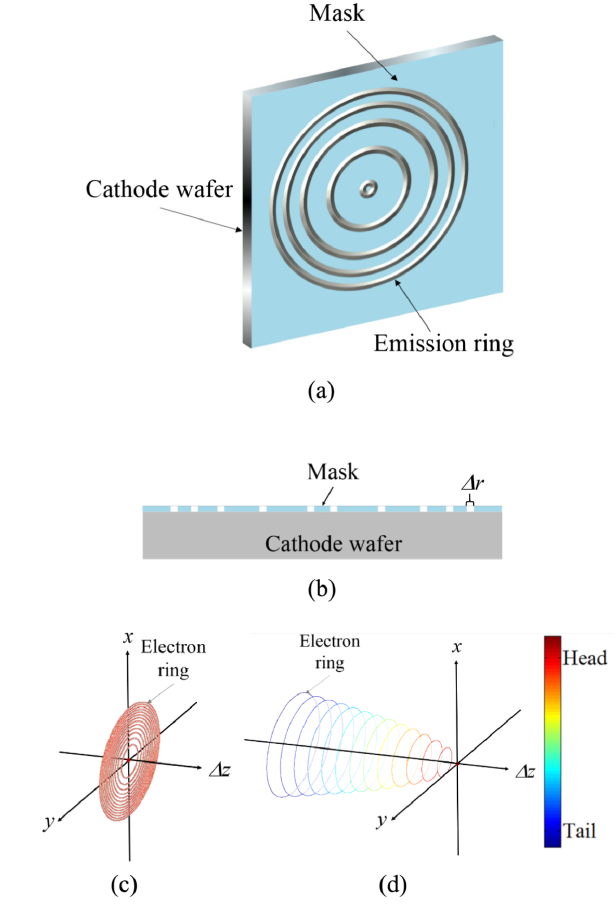
FIG. 4. (a) Illustration of a multiring structured photocathode. The pattern of the uncovered cathode surface is in the form of concentric rings. (b) Cross section view of the structured photo- cathode. The cathode material uncovered by the mask emits electrons. (c) Spatial distribution of the emitted electrons at the cathode. (d) At the accelerator exit, the concentric electron rings at the cathode are longitudinally separated by the radially dependent rf fields during acceleration.